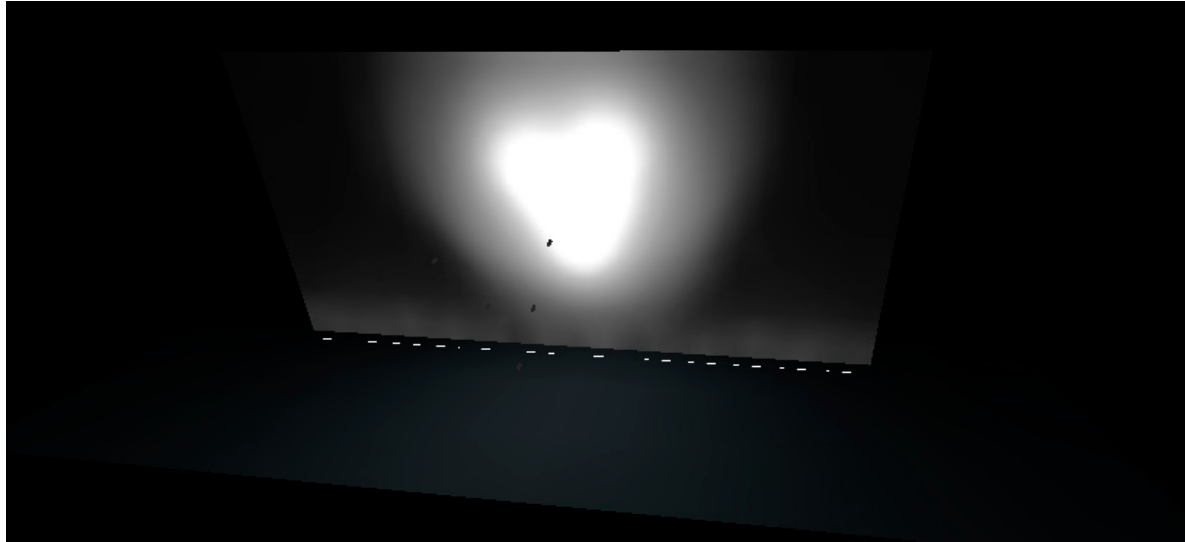
Figure 14. Simulation of visual result of Working Diagram II—Scene 1.